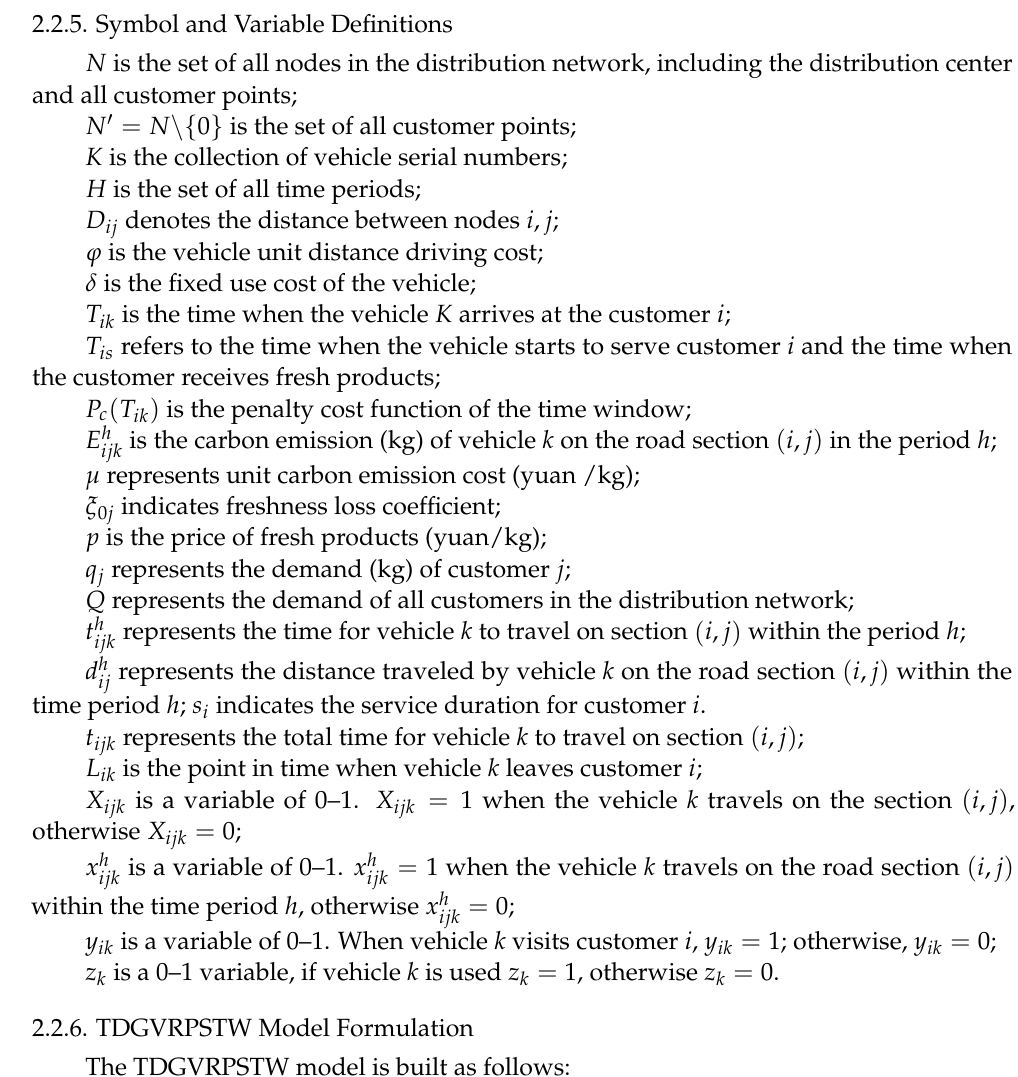
Figure 2. Penalty cost curve under the broken line soft time window.